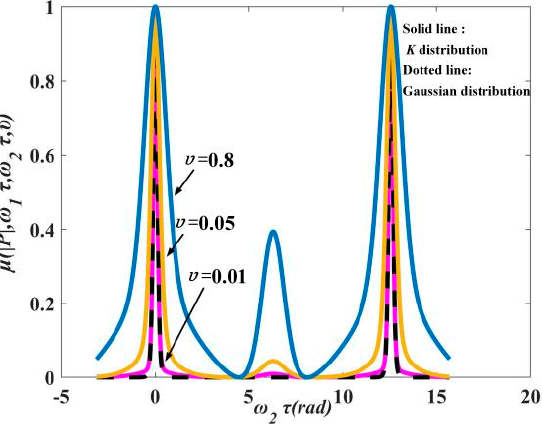
Figure 3. Relationship of temporal correlation function with the value of ω 2 τ for various values of υ .